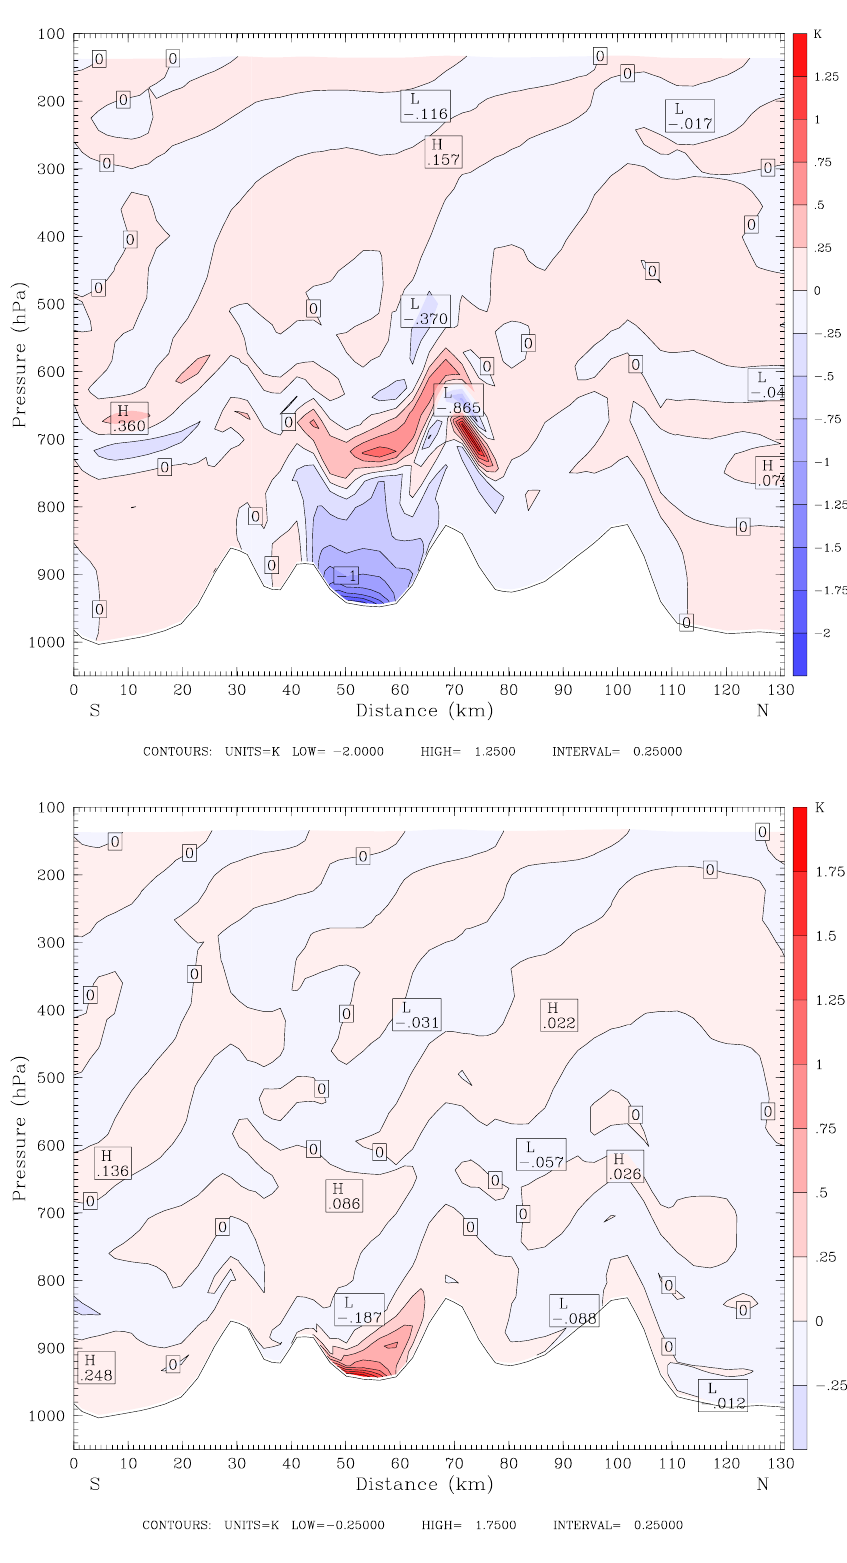
Fig. 9. East-west vertical cross section of temperature difference between the lake SUMWF experiment and the corresponding no-lake experiment at (a) 02 July 1999, 12:00GMT (daytime), and (b) 02 July 1999, 00:00GMT (nighttime) units are